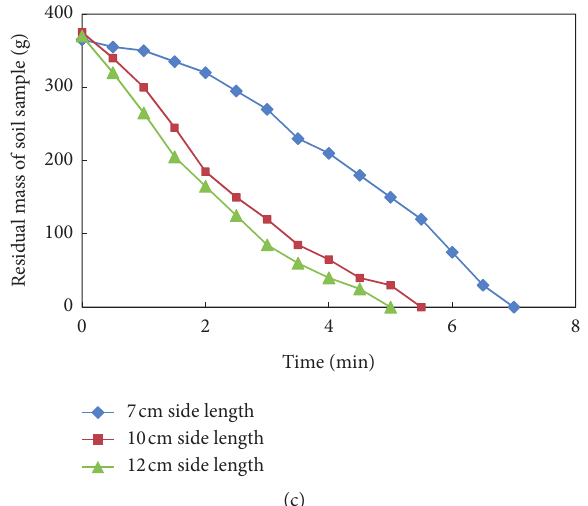
Figure 6: Disintegration curve of soil samples with the same volume and different side length, (a) − 18cm, (b) − 30cm, (c) − 42 cm.